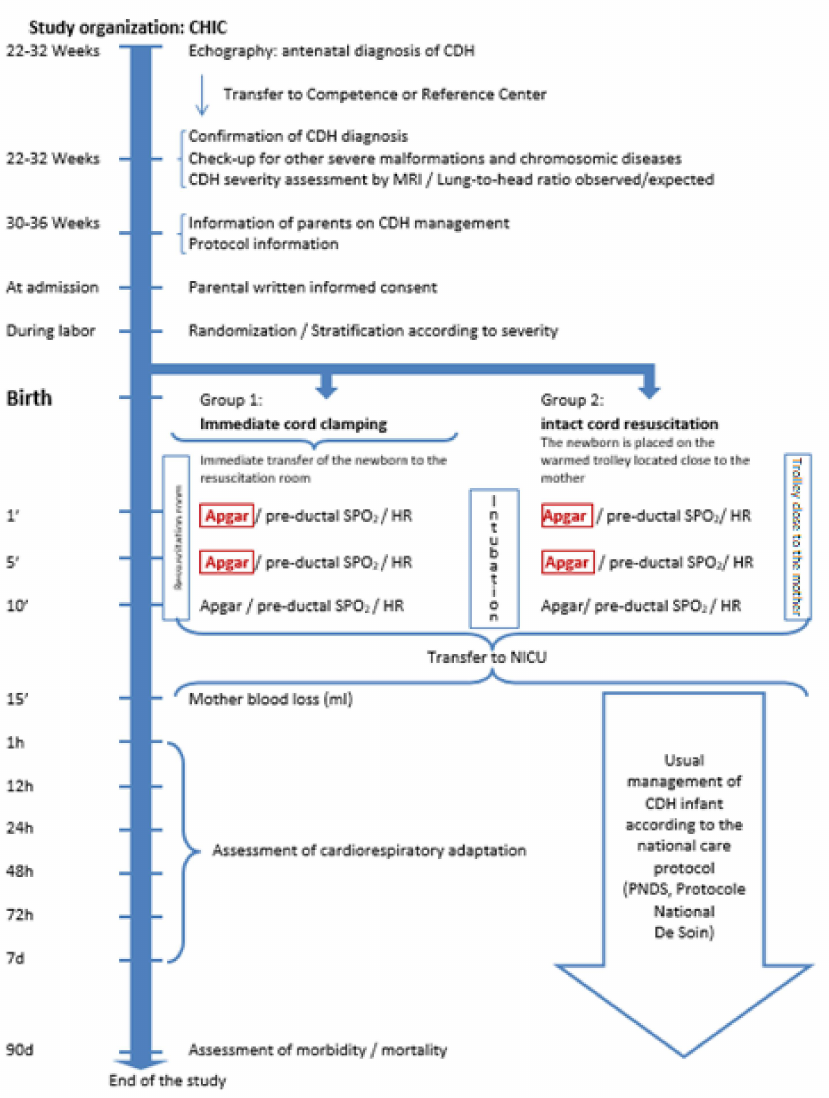
Figure 1. Study organization. Congenital Diaphragmatic Hernia (CDH); Congenital Hernia Intact Cord (CHIC); Blood oxygen saturation (SpO 2 ); Heart Rate (HR); Neonatal Intensive Care Unit